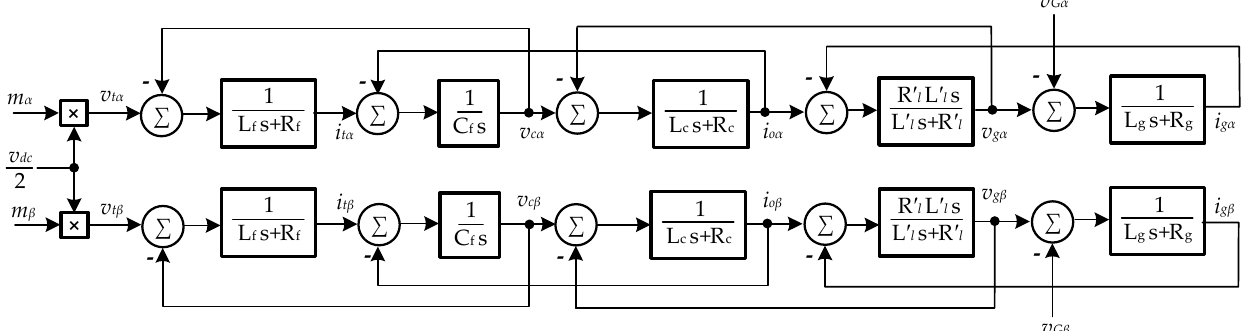
Figure 10. The complete dynamic model of the VSC, load, and transmission line represented in the 𝛼𝛽 frame.